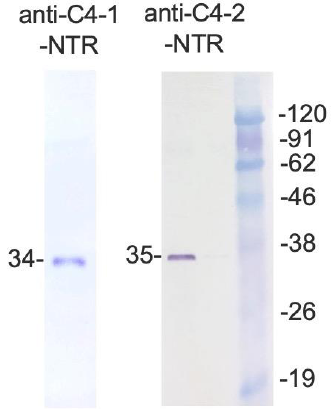
Figure 3. Western blotting of the C4-rich fraction, eluted at 25 min in Figure 2A, with anti-C4-1-NTR and anti-C4-2-NTR separated under reducing conditions. Molecular masses (kDa) of γ-chains of C4- 1 and C4-2 are shown on the left, and those of marker proteins (run in the rightmost lane) are on the right.